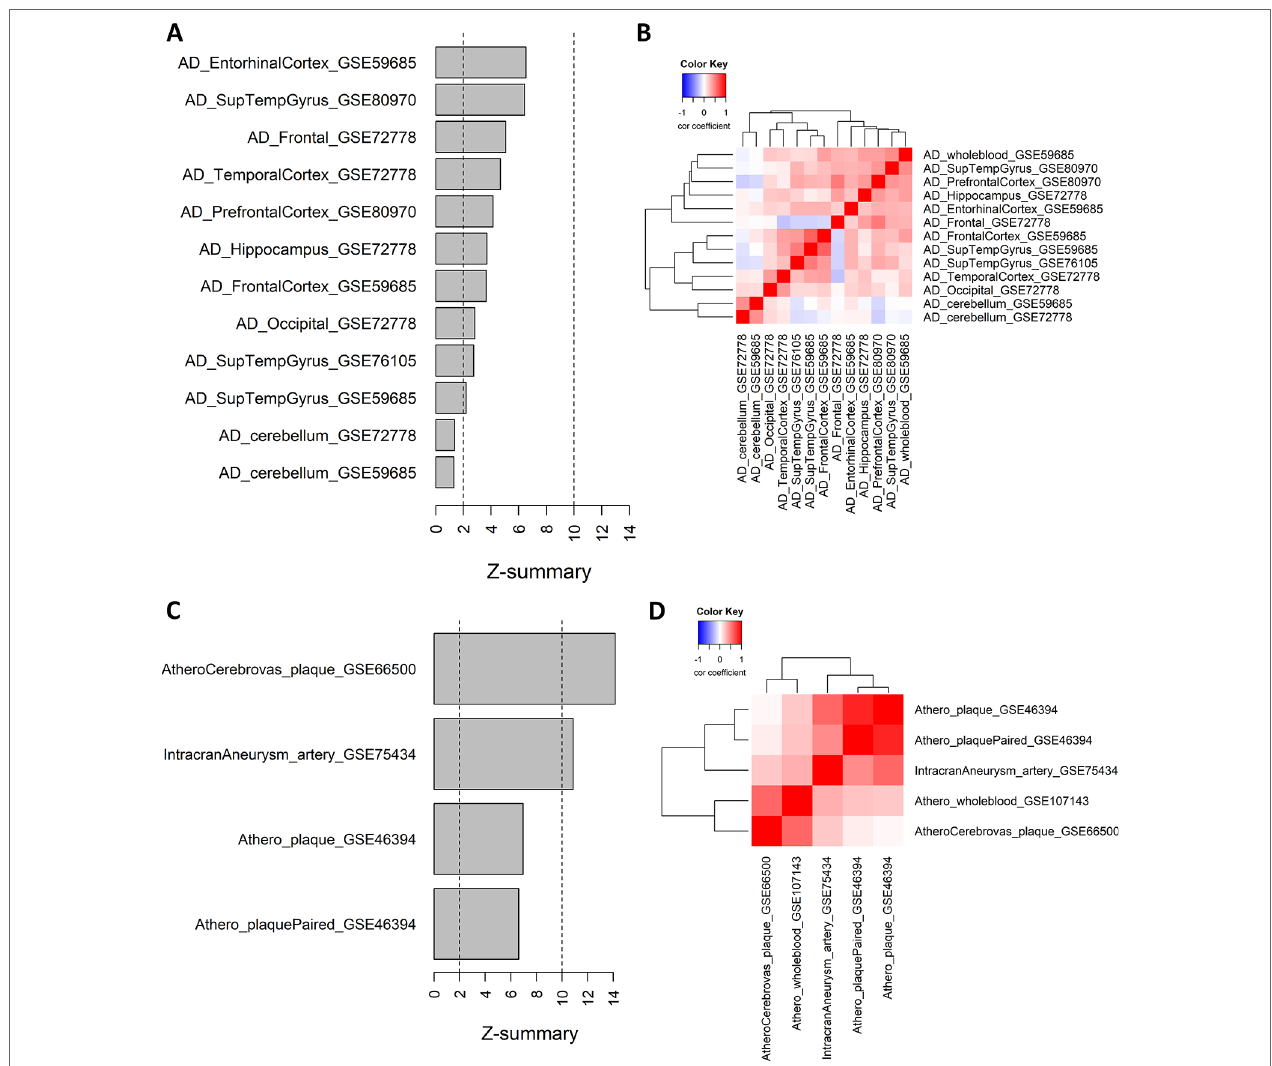
FIgURe 3 | Weighted Correlation Network Analysis consensus module in Alzheimer's disease (AD) brain tissues and atherosclerotic plaques. (A) Consensus module ME21 preservation in AD tissue datasets. For each dataset the preservation z-score is shown. Z-scores below 2 indicates no preservation, between 2 and 10 weak to moderate preservation and above 10 strong preservation. Info about the datasets can be found in Table 1 . (B) Correlation heatmap representing the Pearson's correlation coefficients between the gene significance values (t-statistics) of the consensus module ME21 CpG sites across different AD datasets. Red means a positive correlation and blue a negative correlation. (C) Consensus module ME21 preservation in atherosclerosis and cardiovascular disease (CVD) datasets (see Table 1 ). (D) Correlation heatmap representing the Pearson's correlation coefficients between the gene significance values (t-statistics) of the consensus module CpG sites across different CVD datasets. Red means a positive correlation and blue a negative correlation.